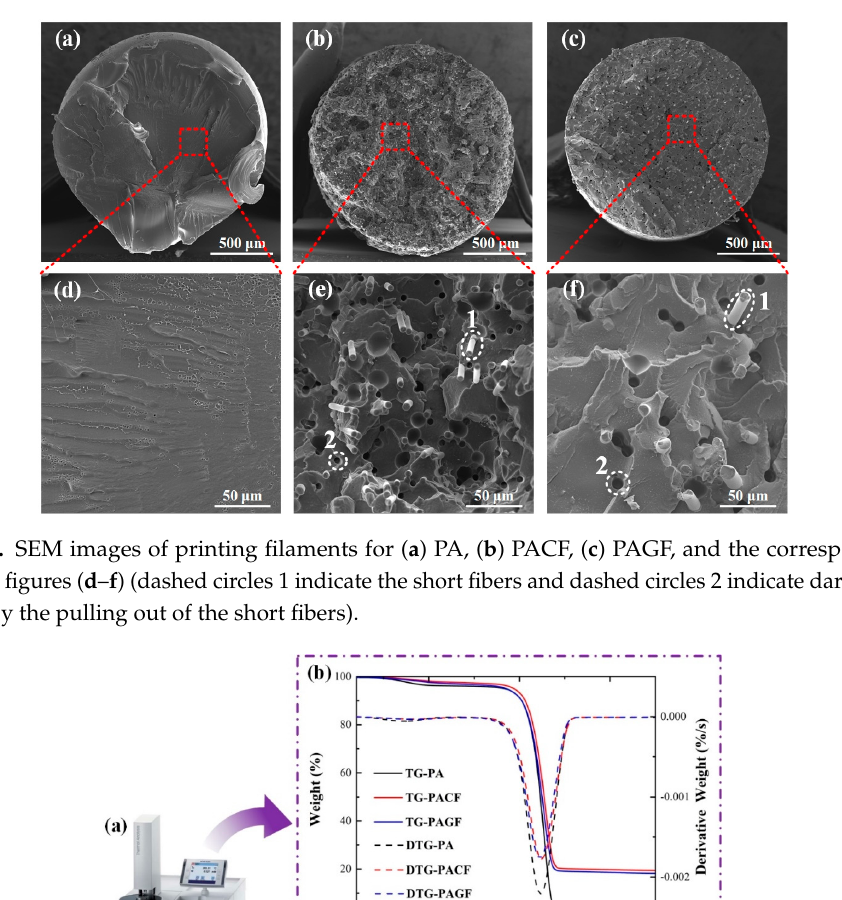
Figure 6. Melt flow index (MFI) of PA, PAGF, and PACF at different temperatures. 3.2. Morphological Properties of Printed Composites Figure 7 presents the cryofractured cross-sectional morphologies of PAGF and PACF built in horizontal direction and at 250 °C. The morphological properties of the specimen built in other directions and at other temperatures were not shown here because their morphological behaviors were similar. Compared with the preferred orientation of short fibers in printing filament (see Figure 4), the fibers in printed samples were significantly combed along the line deposition direction, attributing to the smaller nozzle diameter of the printer rather than the filament extruder one. The highly orientated fibers demonstrated that the melt flow of the materials during the printing process could have an important effect on the morphological characteristics. Therefore, the mechanical